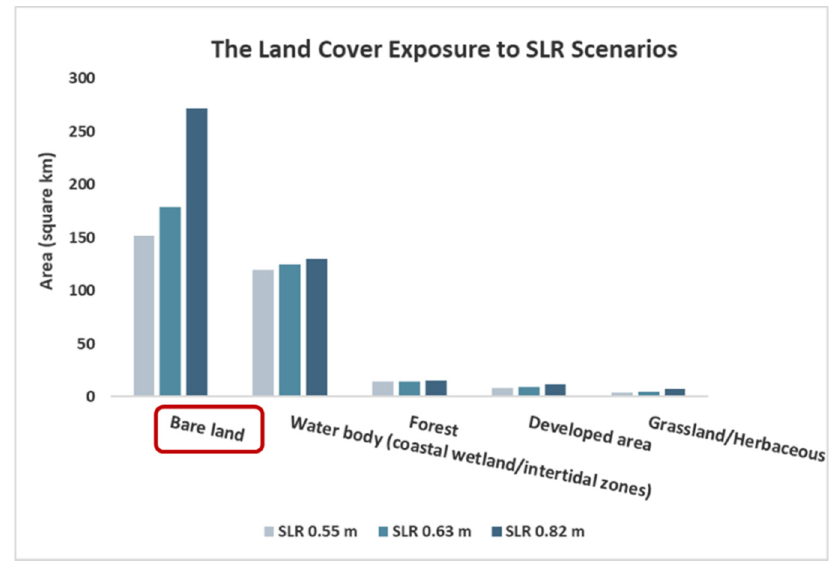
Figure 5. The types and extent of exposed coastal lands to the high-end estimates of SLR.